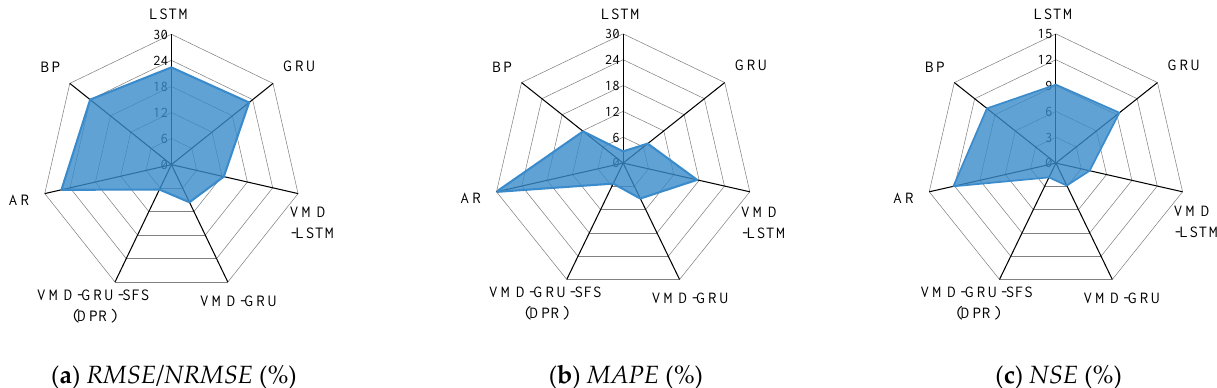
Figure 9. Improvement rates in terms of statistical Indexes in the testing stage of the proposed method for runoff forecasts at the Pingshan station, as compared with the different models. ( a ) RMSE / NRMSE improvement rate; ( b ) MAPE improvement rate; ( c ) NSE improvement rate.